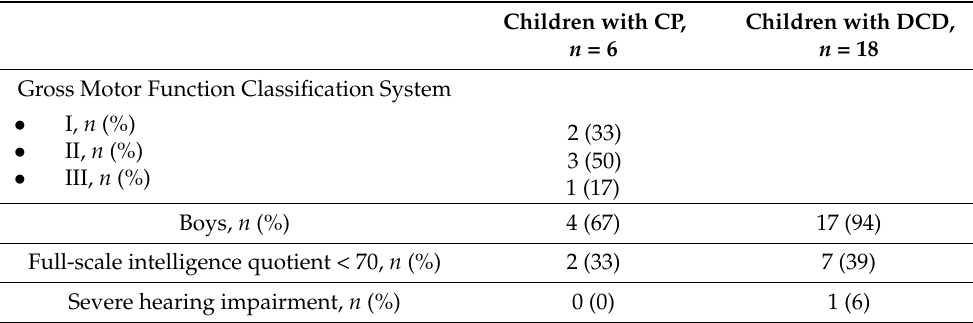
Table 2. Characteristics of children born very preterm with cerebral palsy (CP) and developmental coordination disorder (DCD).